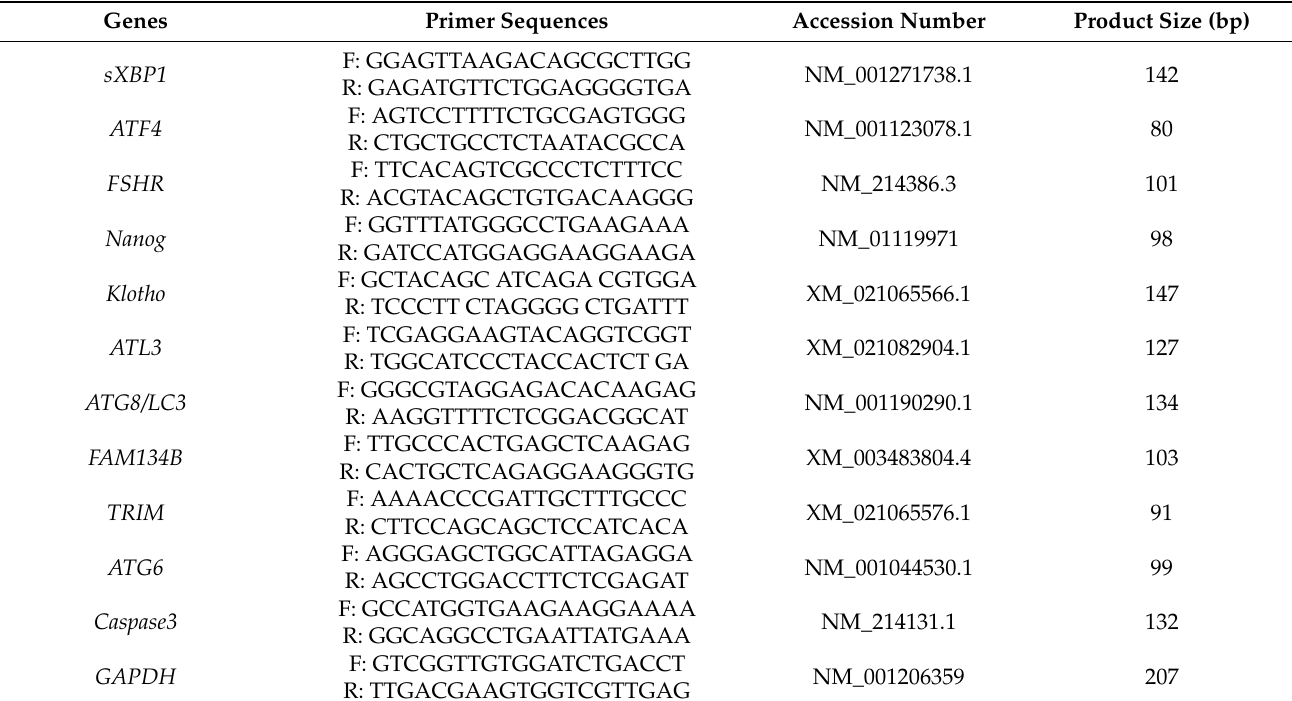
Table 2. Primer gene sequences information for mRNA expression